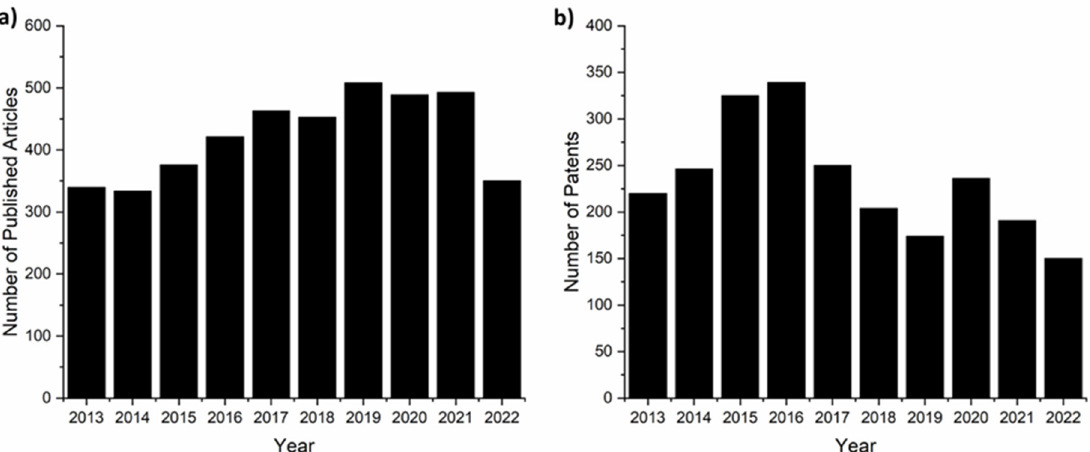
Figure 2. Trend of published ( a ) papers and ( b ) patents for artificial nacre. Data extracted from Web of Science for papers and Lens for patents.